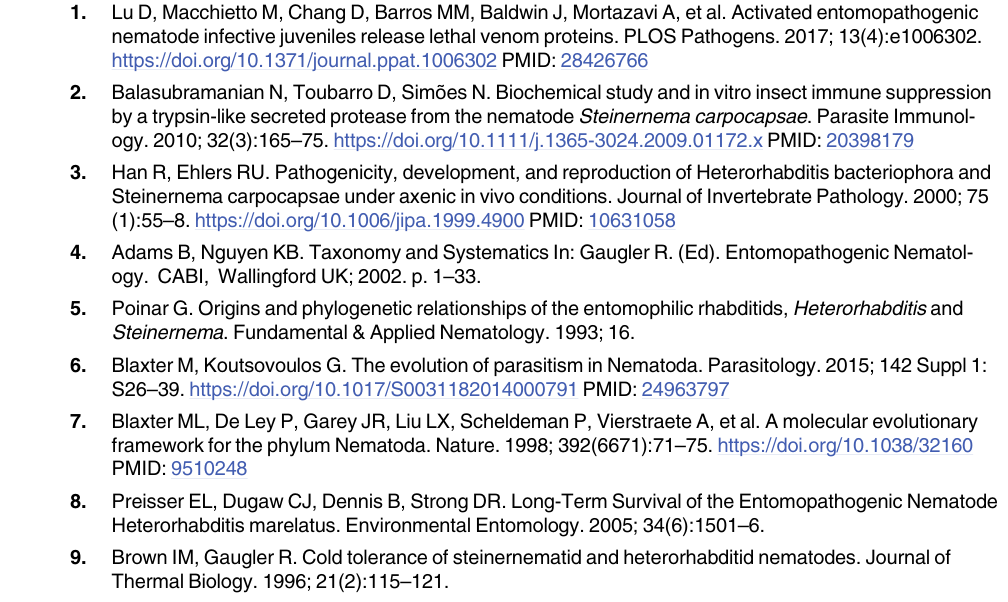
S2 Table. Relative abundances of H . megidis proteins. Log megidis IJs after